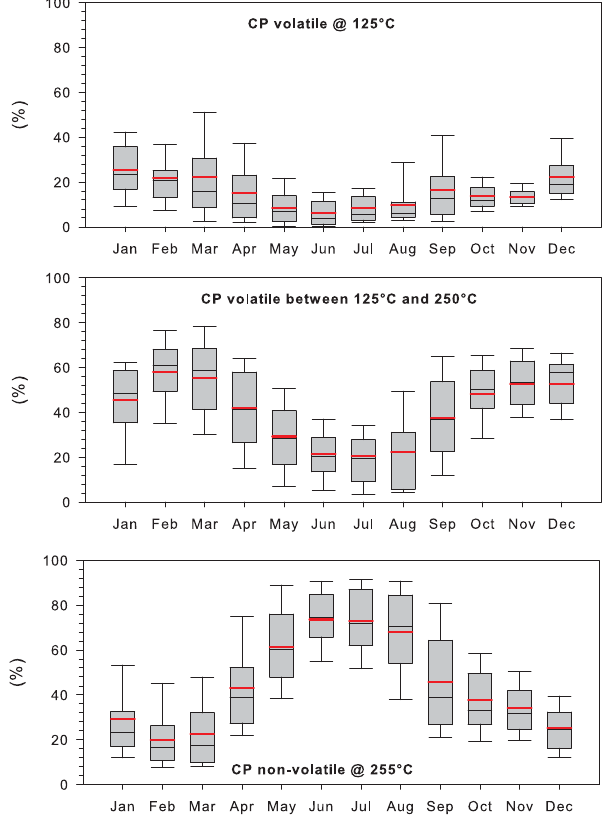
Fig. 4. Box plots of the mean seasonality of the volatile, semi- volatile and refractory portion of the measured particle concentra- tions for the years 2005–2007. Lines in the middle of the boxes represent sample medians (mean: red line), lower and upper lines of the boxes are the 25th and 75th percentiles, and whiskers indicate the 10th and 90th